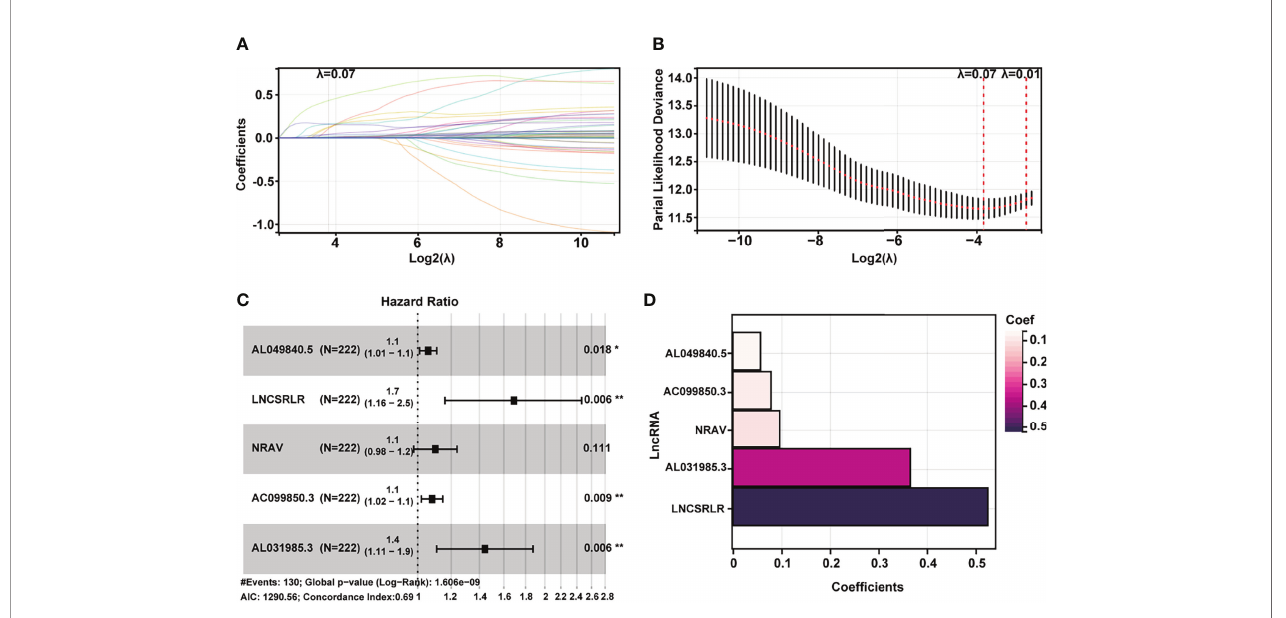
FIGURE 2 | Construction of a 5-ferroptosis-related lncRNA prognostic model. (A, B) Screening of the candidate lncRNAs by LASSO regression analysis. (C) Multivariate Cox regression for the model construction. (D) Model coef fi cients of 5 critical ferroptosis-related lncRNAs. LncRNA, long non-coding RNA; LASSO, least absolute shrinkage and selection